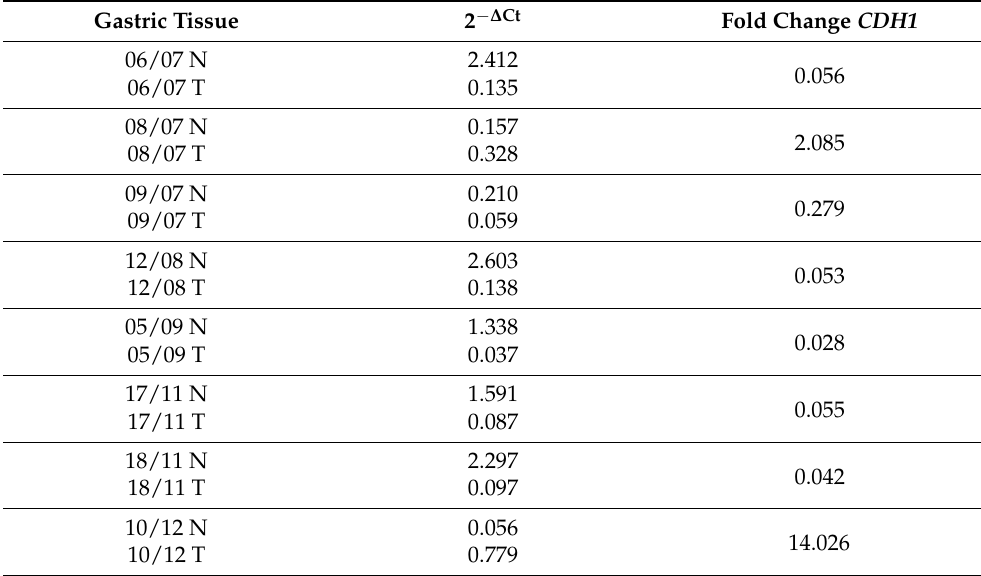
Table 1. Results of CDH1 expression on eight gastric normal (N) and tumor (T) tissues. Gastric